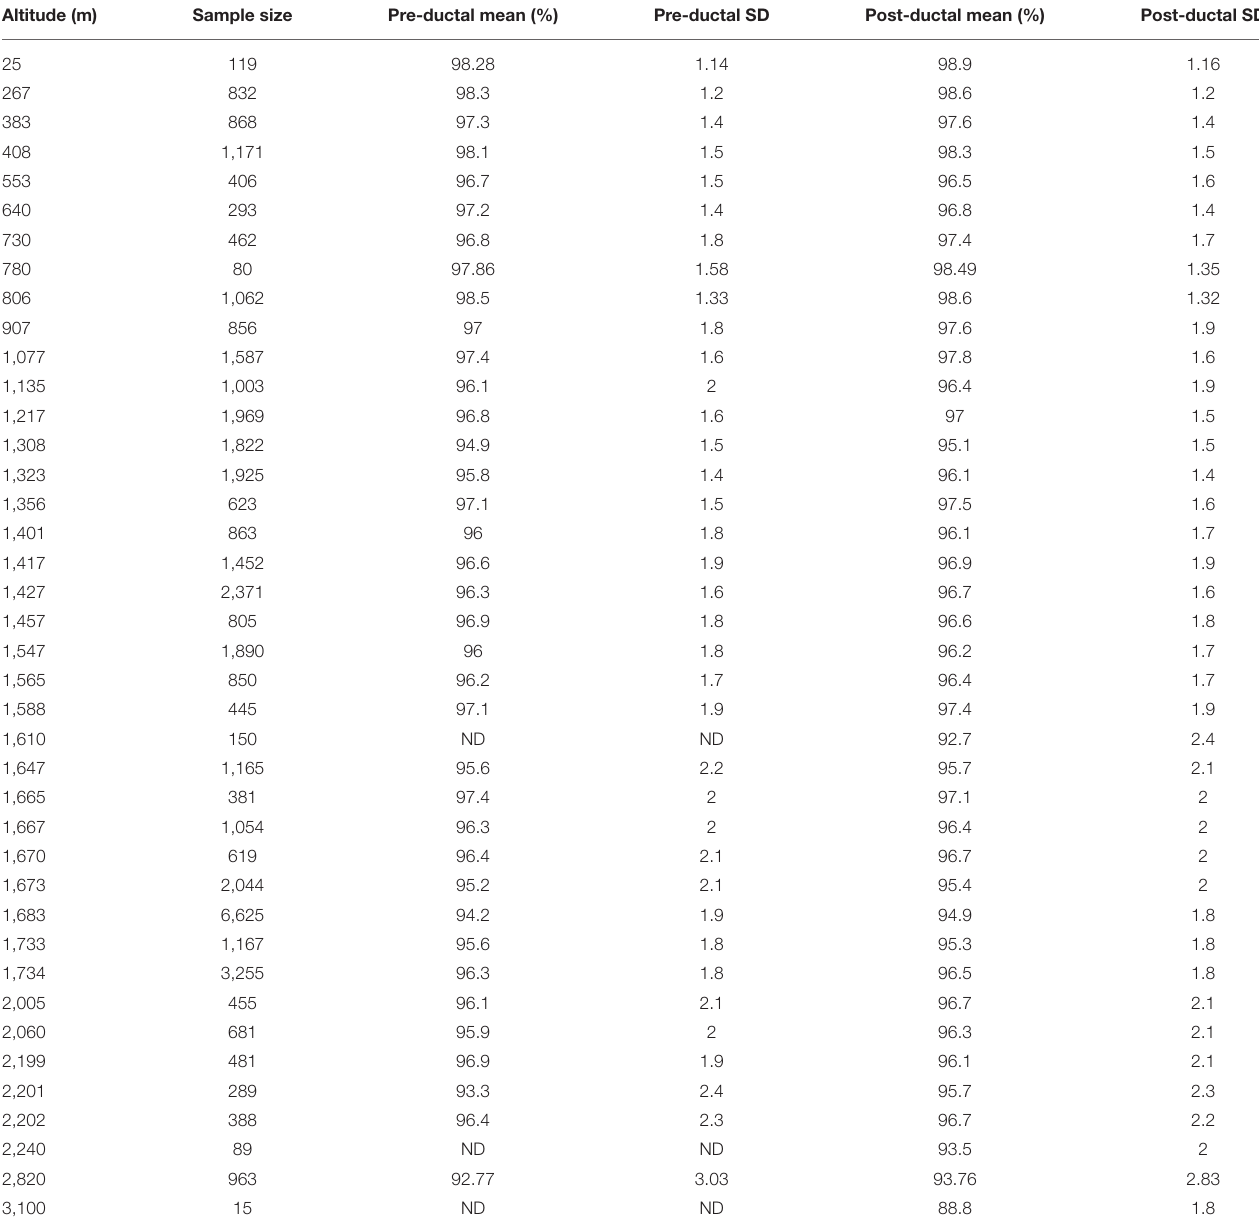
TABLE 3 | SpO 2 in healthy neonates during the stable period at different altitudes. Altitude (m) Sample size Pre-ductal mean (%) Pre-ductal SD Post-ductal mean (%) Post-ductal